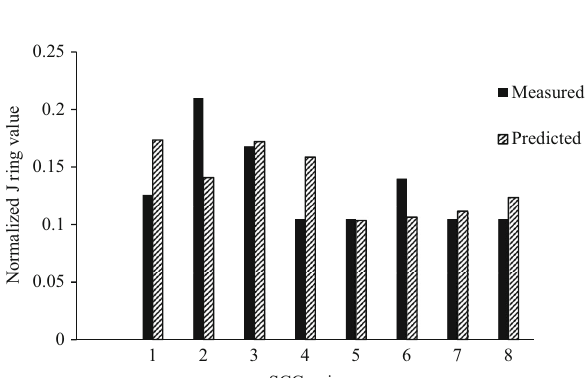
Fig. 4 Measured-versus-predicted normalized values of V funnel time.